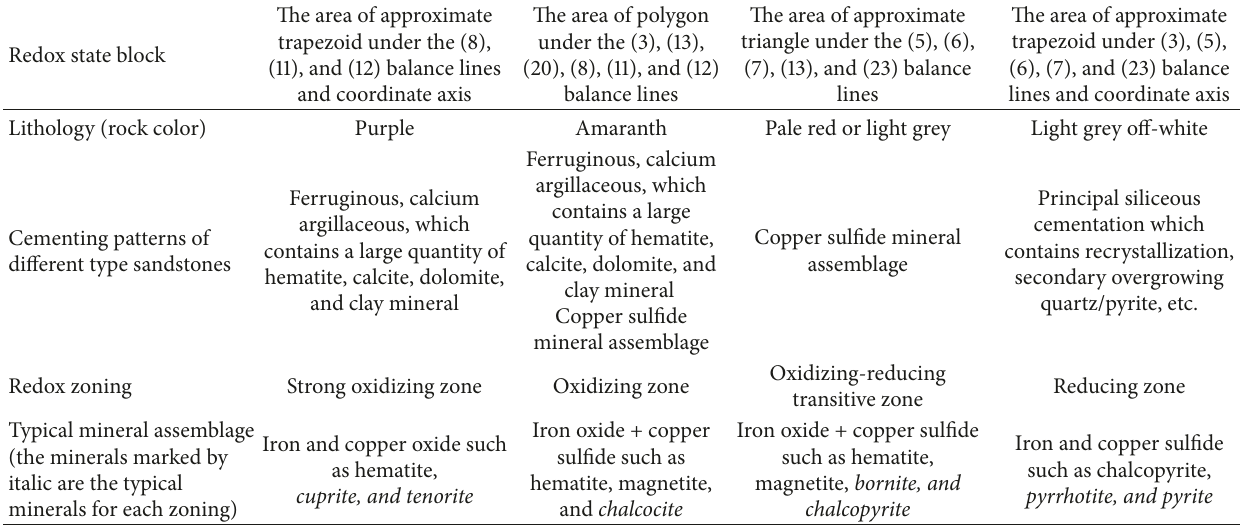
Table 5: Comparison of log 𝑓